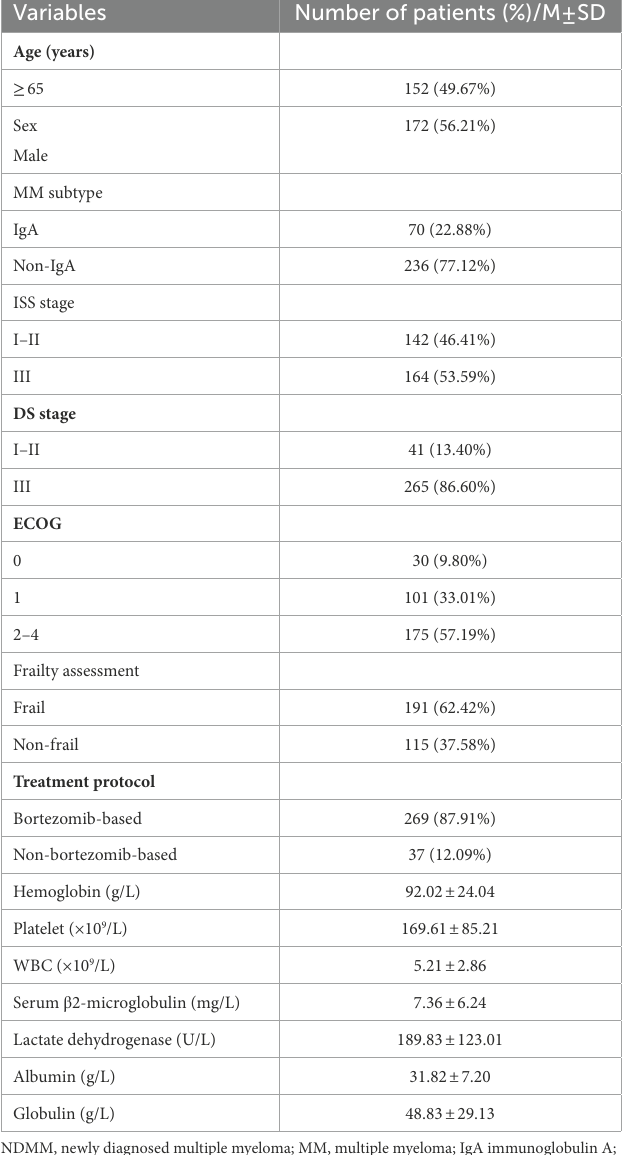
TABLE 1 Baseline clinical characteristics of the patients with newly diagnosed multiple myeloma